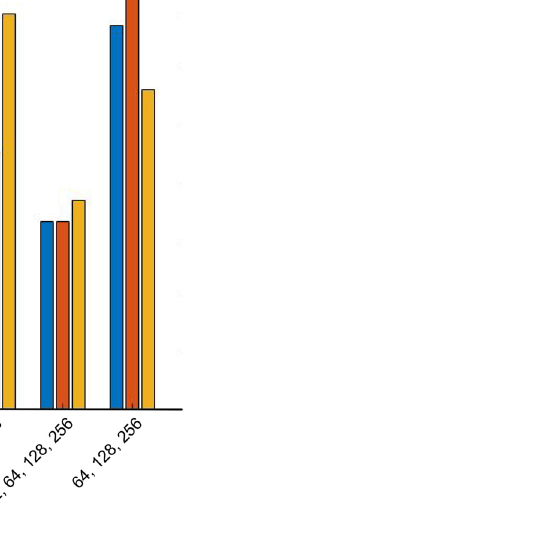
Figure 6. RMSE comparison for weight